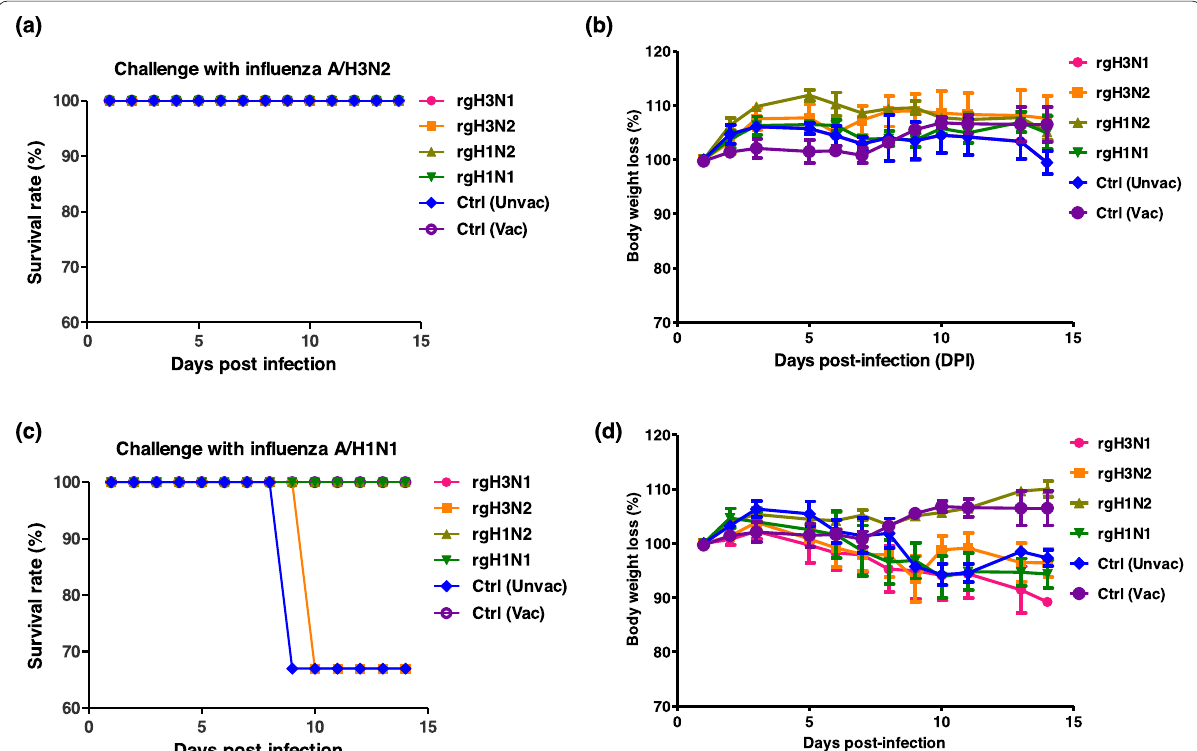
Fig. 7 Survival rate and body weight losses of vaccinated mice ( n 8 per each virus challenge) against circulating IAVs. Vaccinated mice that = were infected with influenza A/H3N2 followed by monitoring the survival rate percent ( a ) and body weight loss percent ( b ). The second group of vaccinated mice was challenged with influenza A/H1N1 and protectiveness was investigated by following up on the survival rate percent ( c ) and body weight loss percent ( d